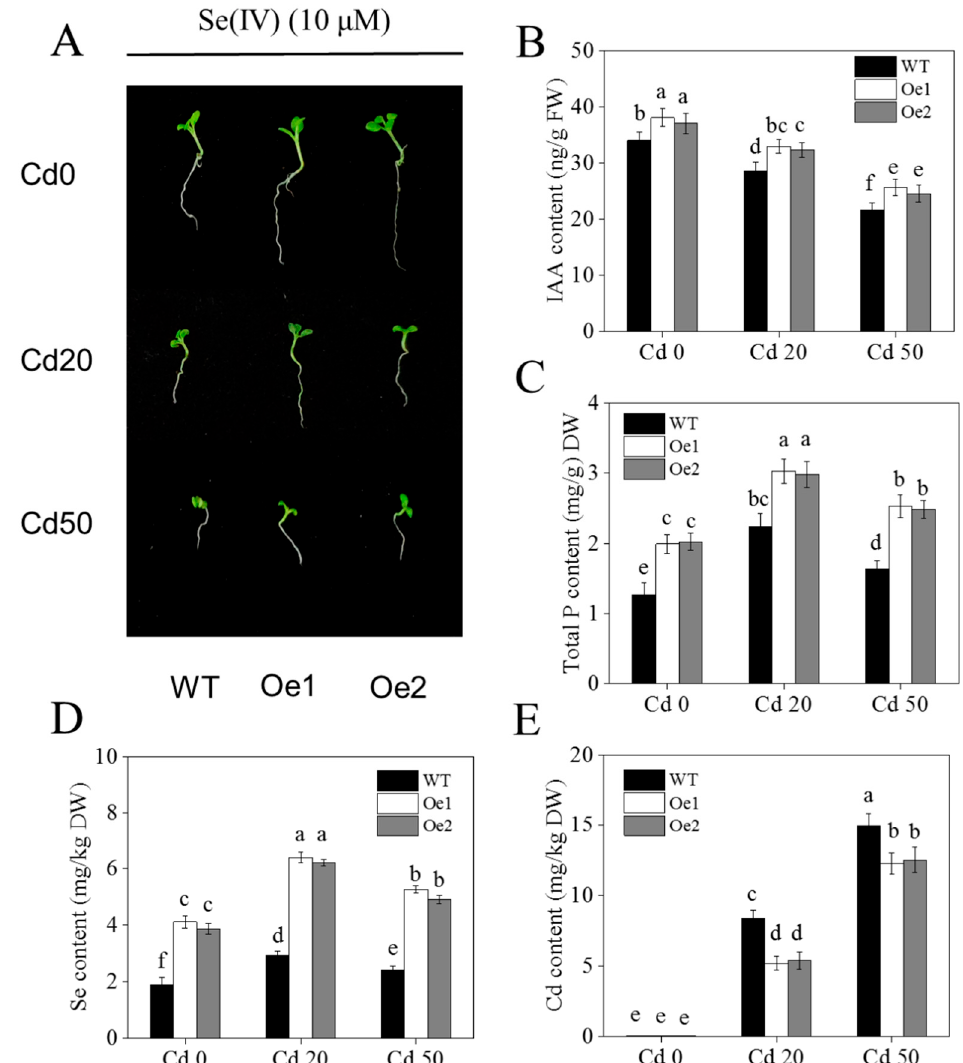
Figure 6. E ff ects of Cd on NtPT2-Oe transgenic tobacco under di ff erent Se and Cd concentration supply conditions. ( A , B ) The phenotype and IAA content of NtPT2-Oe transgenic tobacco seedlings in Figure 6. Effects of Cd on NtPT2-Oe transgenic tobacco under different Se and Cd concentration